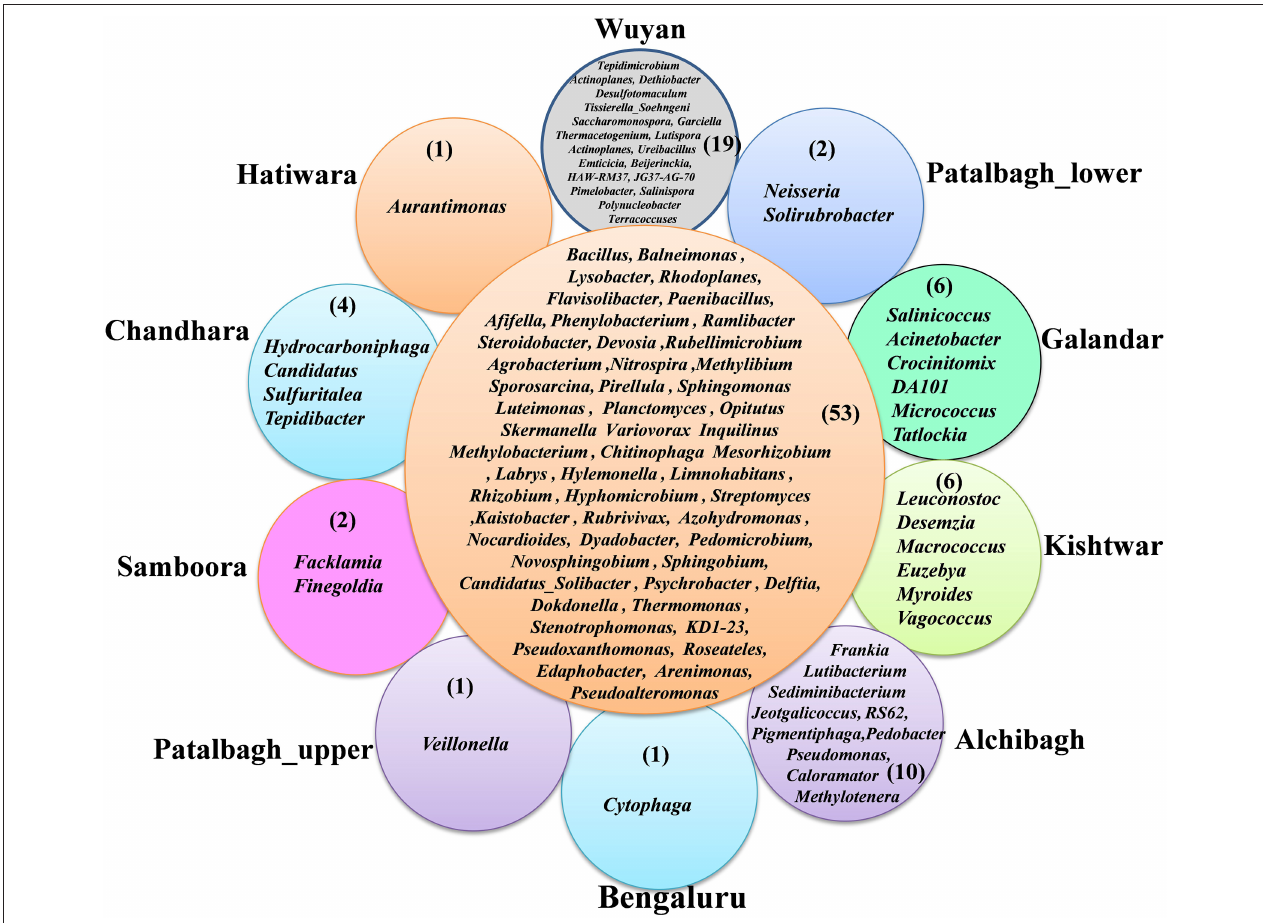
FIGURE 4 | Radical Venn diagram representing the unique genera identified in 10 different locations. Wuyan-Kashmir has the maximum number (19) of unique genera followed by 10 in Alchibagh, 6 in Gullandar and Kishtwar, 4 in Chandhara, 2 in Samboora and Patalbagh_lower range and 1 genera in Hatiwara, Bengaluru, Patalbagh_upper